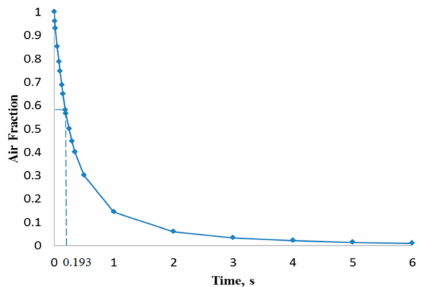
Figure 10. Overall air volume fraction in the chamber vs. filling time at a liquid flow rate of 1000 µ L/min.